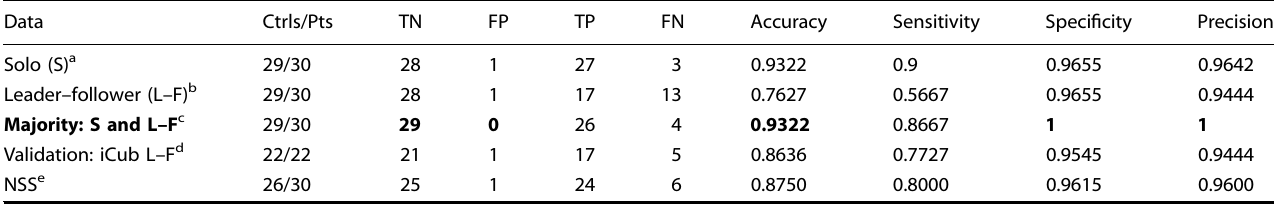
Table 1. Results of classi fi cation based on different features